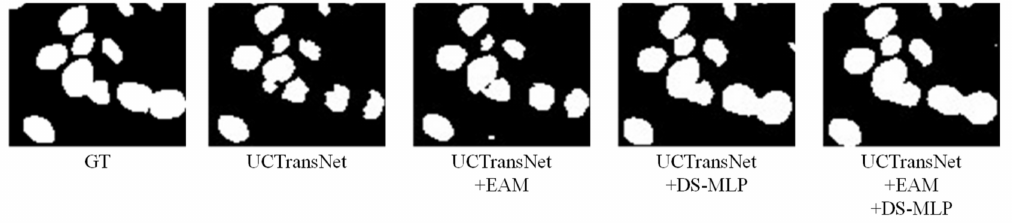
Figure 11. A local enlargement of the visualization result for the fourth line in Figure